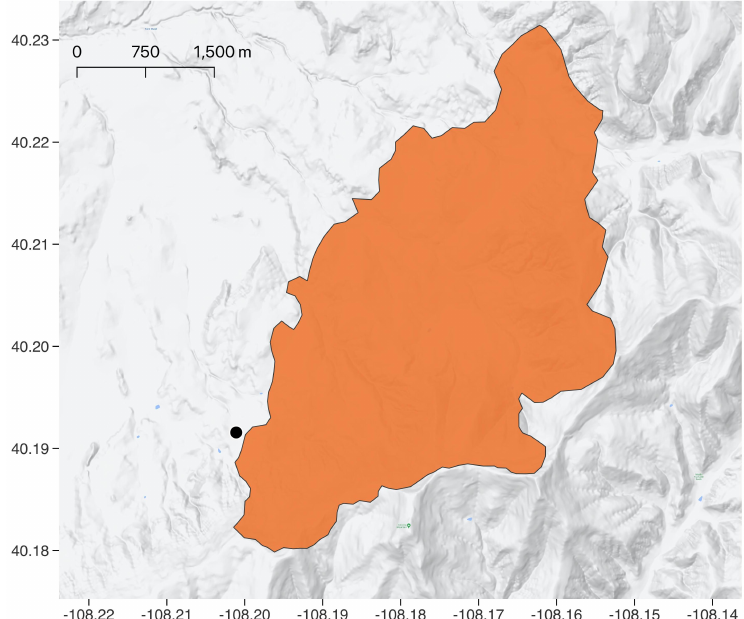
Figure 1. The first observed active fire perimeter (orange) for the Indian Valley Fire, Colorado 2018, and the fire’s initial detection location (black dot). The initial detection location was obtained through the Integrated Reporting of Wildland-Fire Information system [20], and the first observed fire perimeter was obtained through the National Interagency Fire Center [40]. Longitude (decimal degrees) and latitude (decimal degrees) showing the location of this fire are given on the x-axis and y-axis,